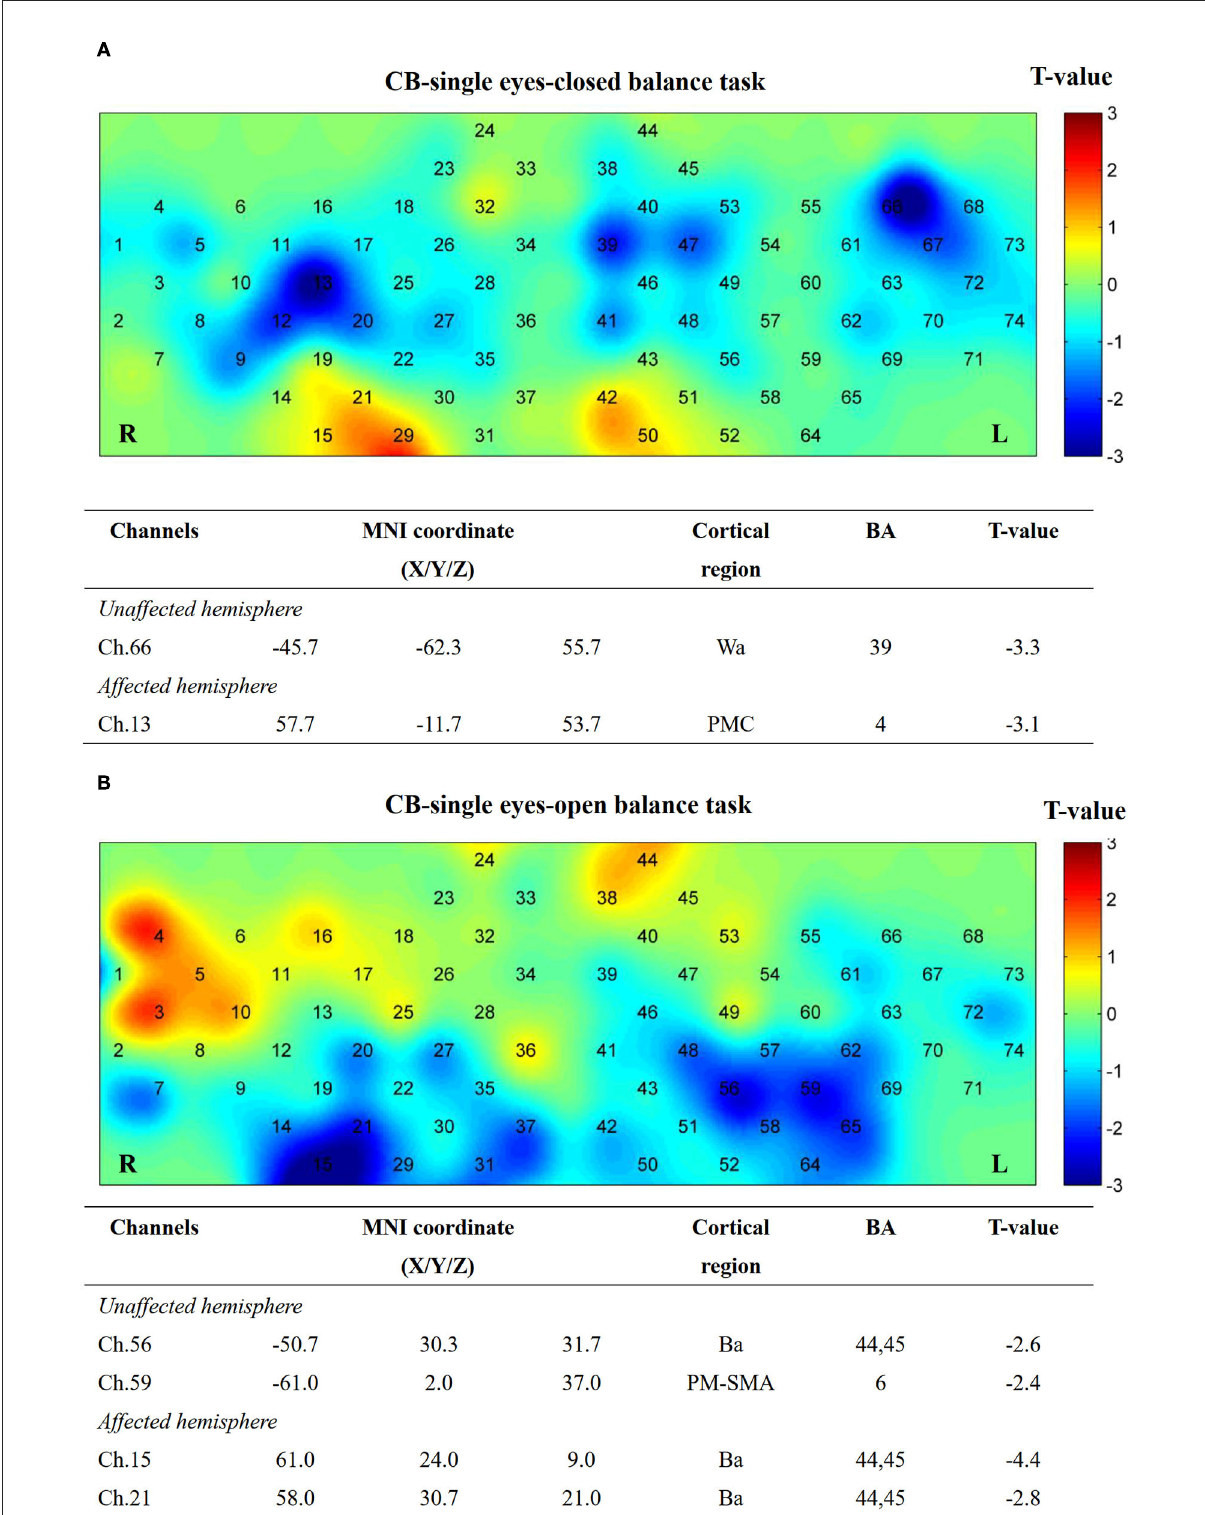
FIGURE9 Cortical activation map in CB-single group in EC condition (A) and EO condition (B) . Results from paired t -test of beta value between post and pre CB-M1 iTBS protocol. None channels passed FDR correction. Channels with a meaningful trend have been